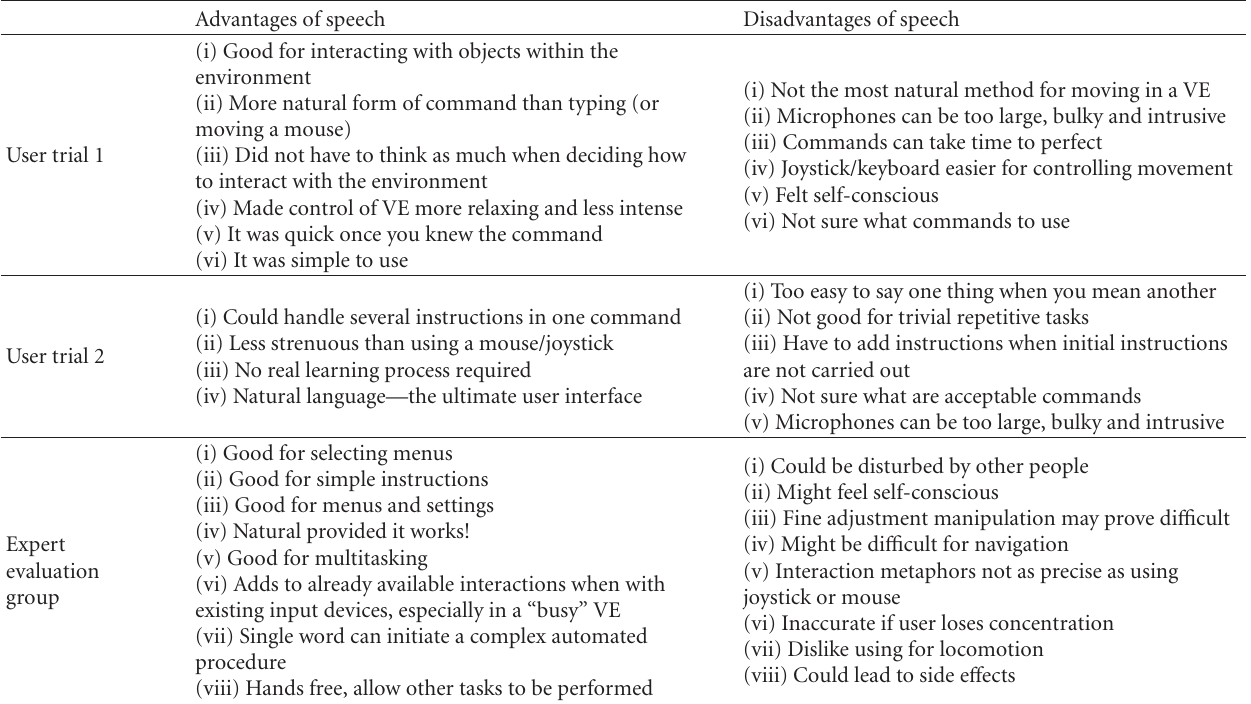
Table 1: Qualitative comments from IDU questionnaire.